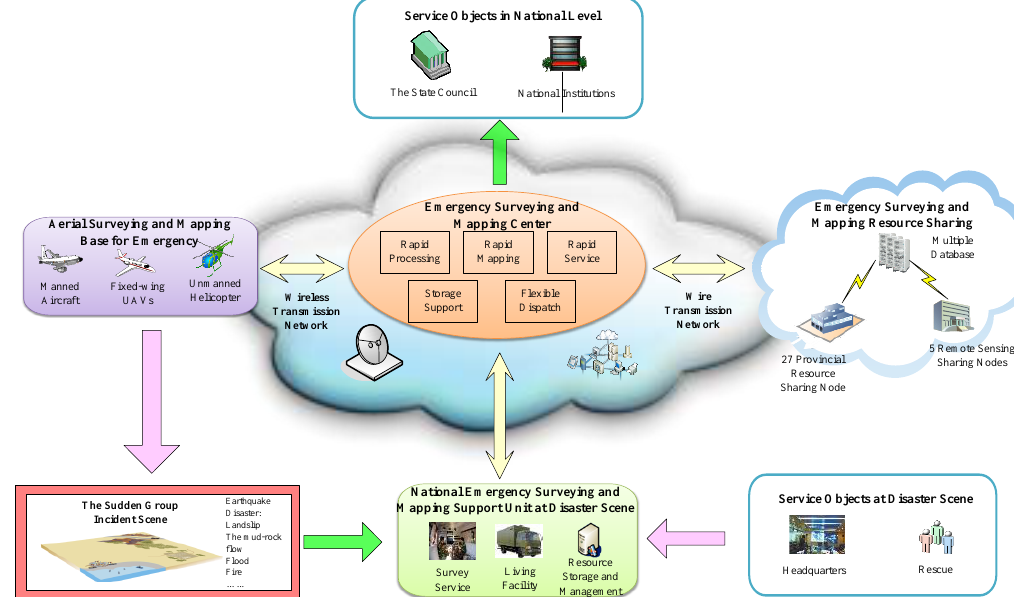
Figure 3. National emergency mapping capacity building